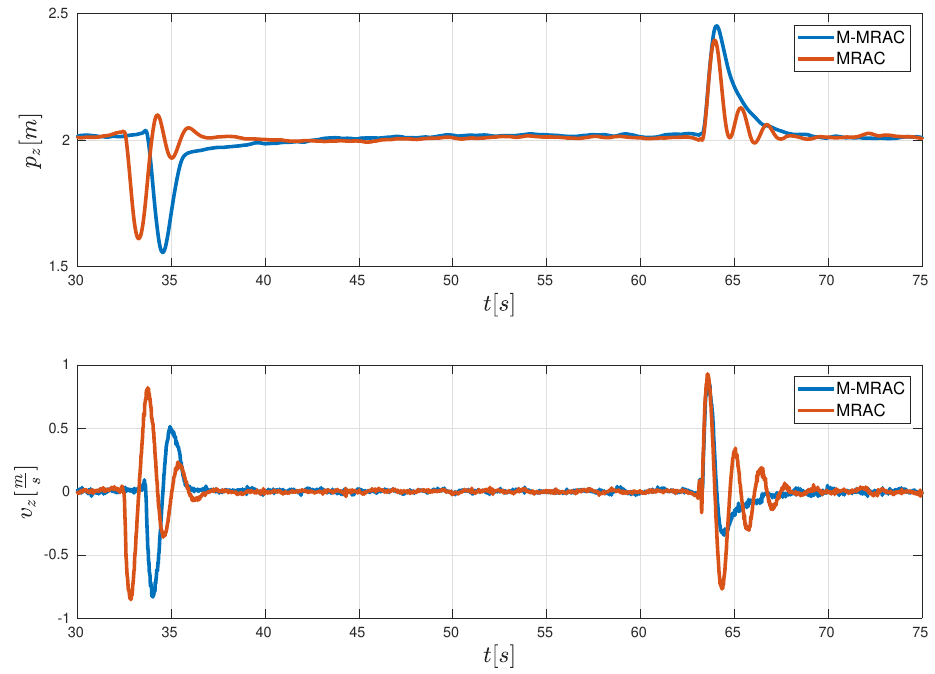
Figure 10. Difference of the additive PID controller for the real